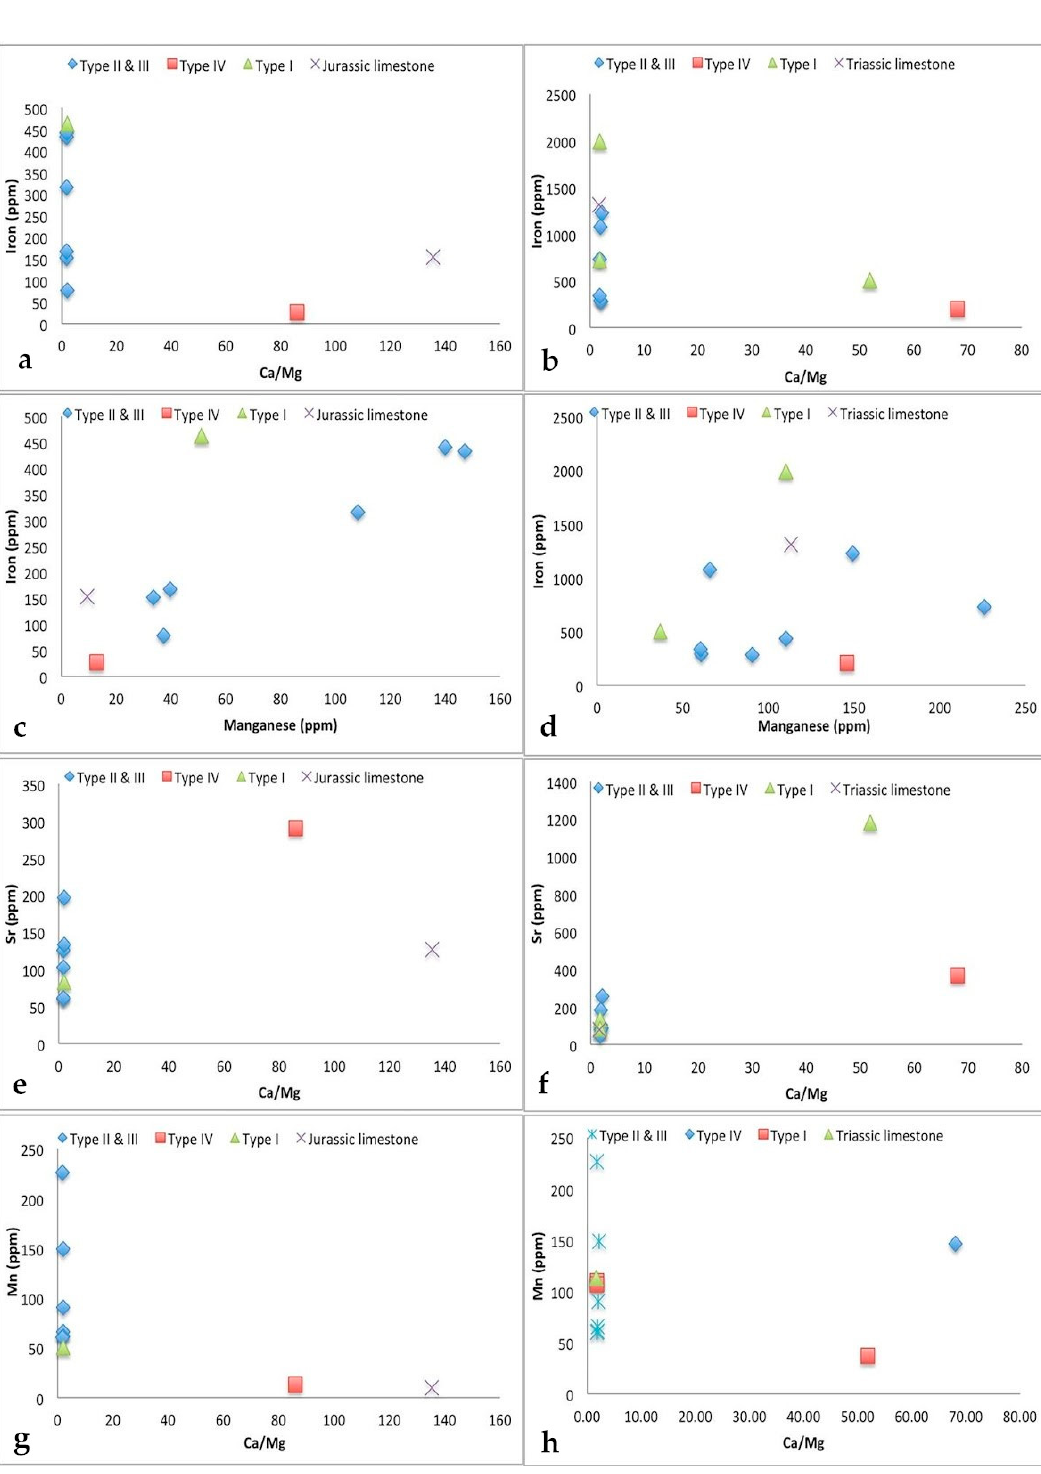
Figure 9. Diagram of the main chemical elements involved in the diagenesis and of the host limestones from the study area ( n = 20). For more detail about Type I, II, III, IV, see text. ( a ) Ca / Mg vs. Fe for Jurassic carbonate samples, ( b ) Ca / Mg vs. Fe for Triassic carbonate samples, ( c ) Mn vs. Fe for Jurassic carbonate samples, ( d ) Mn vs. Fe for Triassic carbonate samples, ( e ) Ca / Mg vs. Sr for Jurassic carbonate samples, ( f ) Ca / Mg vs. Sr for Triassic carbonate samples, ( g ) Ca / Mg vs. Mn for Jurassic carbonate samples, and ( h ) Ca / Mg vs. Mn for Triassic carbonate